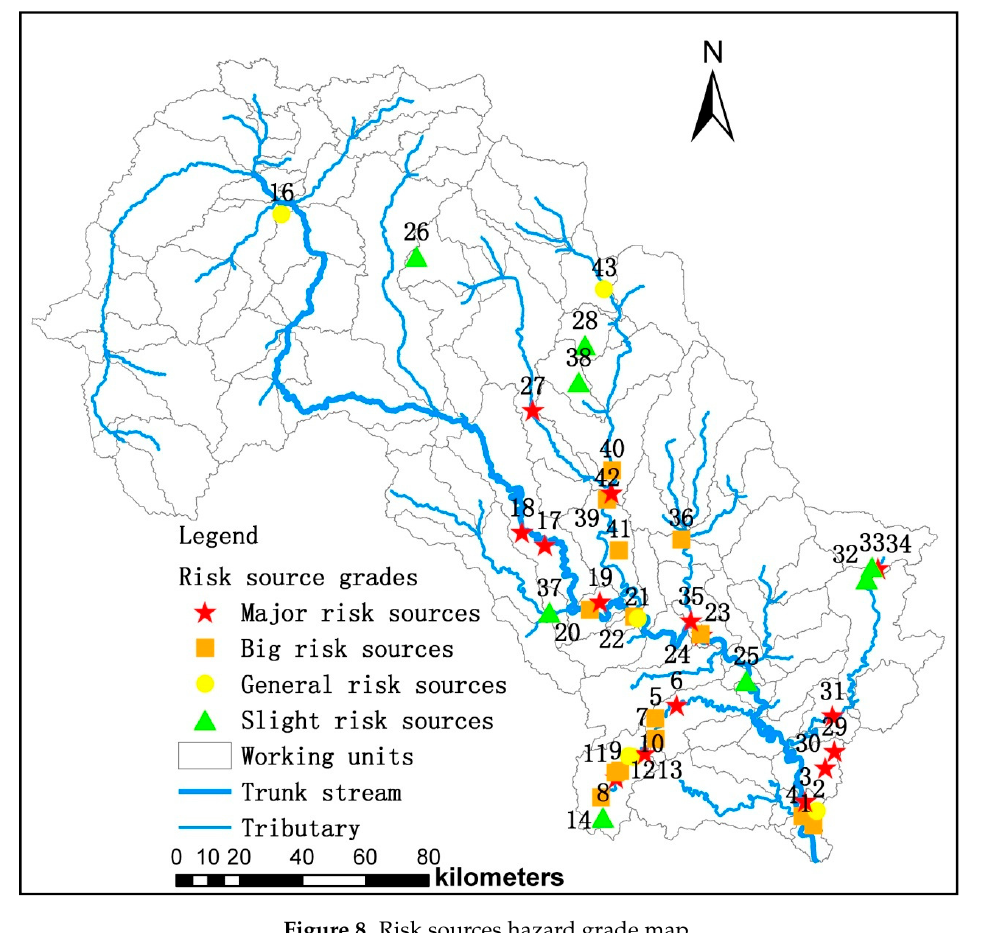
Figure 8. Risk sources hazard grade map. Table 7. Environment risk source name.